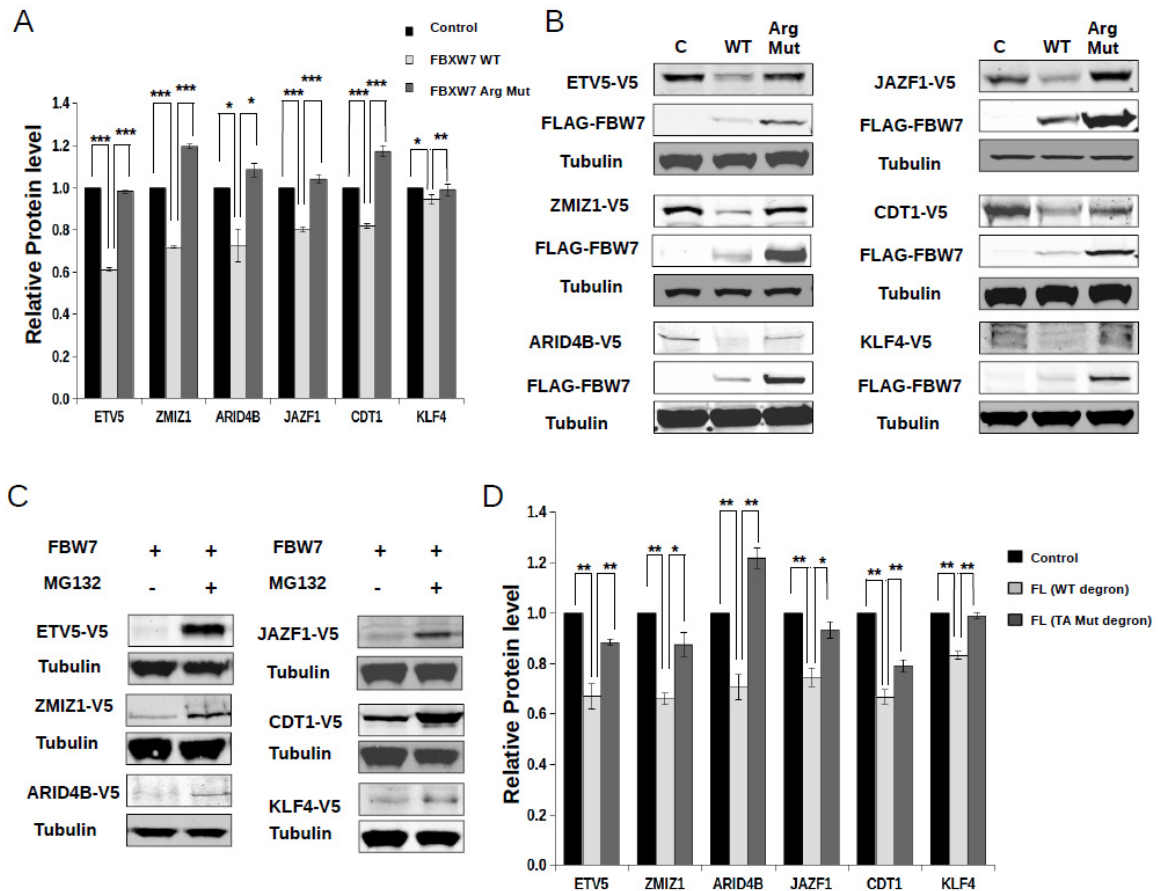
Figure 4. Phosphodegrons in full-length proteins. ( A ) Intact phosphodegron-FXWB7 binding is essential for the regulation of full-length protein levels. The level of full-length proteins containing an FBXW7 interacting phosphodegron were analyzed by the EGFP/DsRed ratiometric assay in HEK293T cells 48 h after transfection with empty plasmid (Control), or with the expression plasmid for wild-type (WT) or mutated FBXW7 (Arg Mut: three arginine amino acids mutated in the WD40 domain important for phosphodegron-FBXW7 binding). ( B ) Similar experiment toPanel A, but pro- tein levels were monitored by western blots. Each full-length protein construct was expressed with a V5-tag and the heterologously expressed FBXW7 constructs had a FLAG-tag. Anti-tubulin was used as the load control. ( C ) FBXW7-mediated degradation of the full-length protein constructs are inhibited by the MG132 proteosomal inhibitor. Western blot analysis was conducted similarly to Panel B. ( D ) Phosphorylation of the phosphodegron motifs in full-length protein constructs is es- sential for their FBXW7 mediated degradation. The experiment was carried out similarly as shown on Panel A. Control: co-transfection with intact full-length protein constructs and empty FBXW7 expression vector; FL (WT degron): co-transfection with intact phosphodegron motif containing full-length constructs and wild-type FBXW7; FL (TA Mut degron): co-transfection with mutated phosphodegron motif (two phosphorylatable residues replaced with alanines) containing full- length constructs and wild-type FBXW7. Relative protein levels show the EGFP/DsRed ratio for the different full-length constructs. Error bars show SD based on three independent experiments. Sta- tistical significance was calculated based on two-tailed, paired Student’s t -test (*: p < 0.05; **: p < 0.01; ***: p < 0.001). 2.4. Protein Kinase Mediated Phospho-Regulation of FBXW7 Binding Degrons GSK3 was earlier shown to affect the degradation rate of many known FBXW7 client proteins [40]. In order to test if the degradation of the new full-length constructs can be